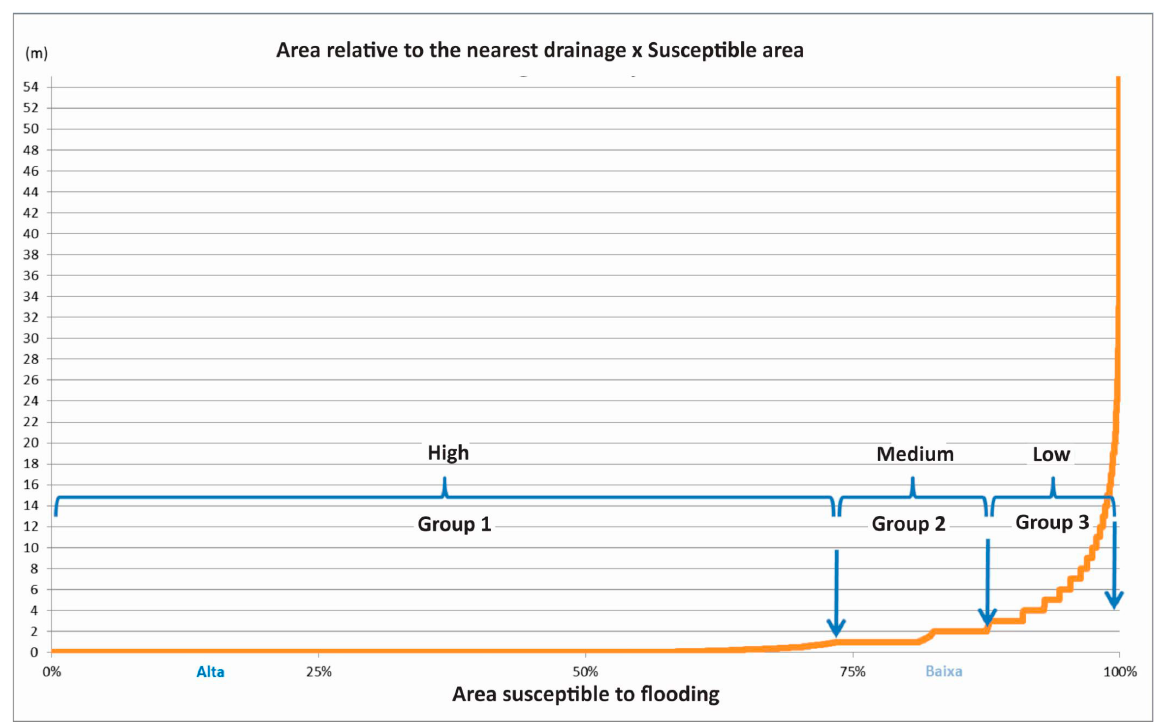
Figure 12 - Graph correlating the height relative to the nearest thalweg (HAND) with the flooding susceptible area in Presidente Kennedy, ES. The high susceptibility class had a threshold close to 70%. The moderate class had an upper threshold value close to 85% and the low class, above